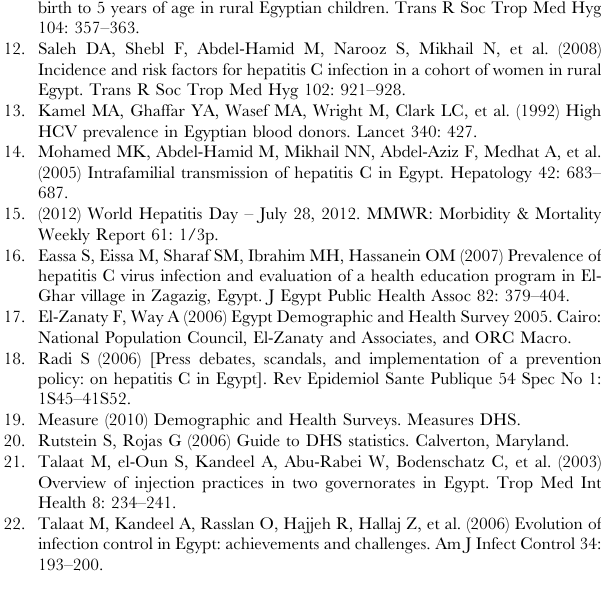
Table S1 Knowledge of hepatitis C virus questions as collected in the Egyptian Demographic and Health Survey,